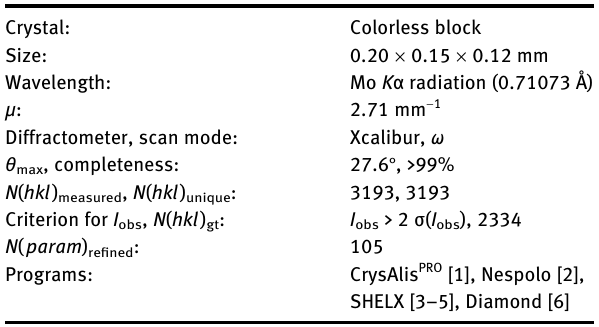
[ − 100]. Table 1 contains crystallographic data and Table 2 contains the list of the atoms including atomic coordinates and displacement parameters.